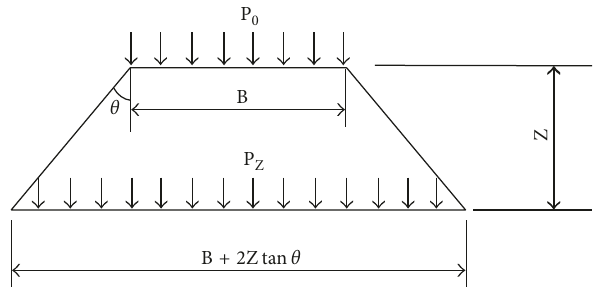
Figure 15: Stress diffusion of the cushion. Table 6: The summary of stress diffusion angles. Test number